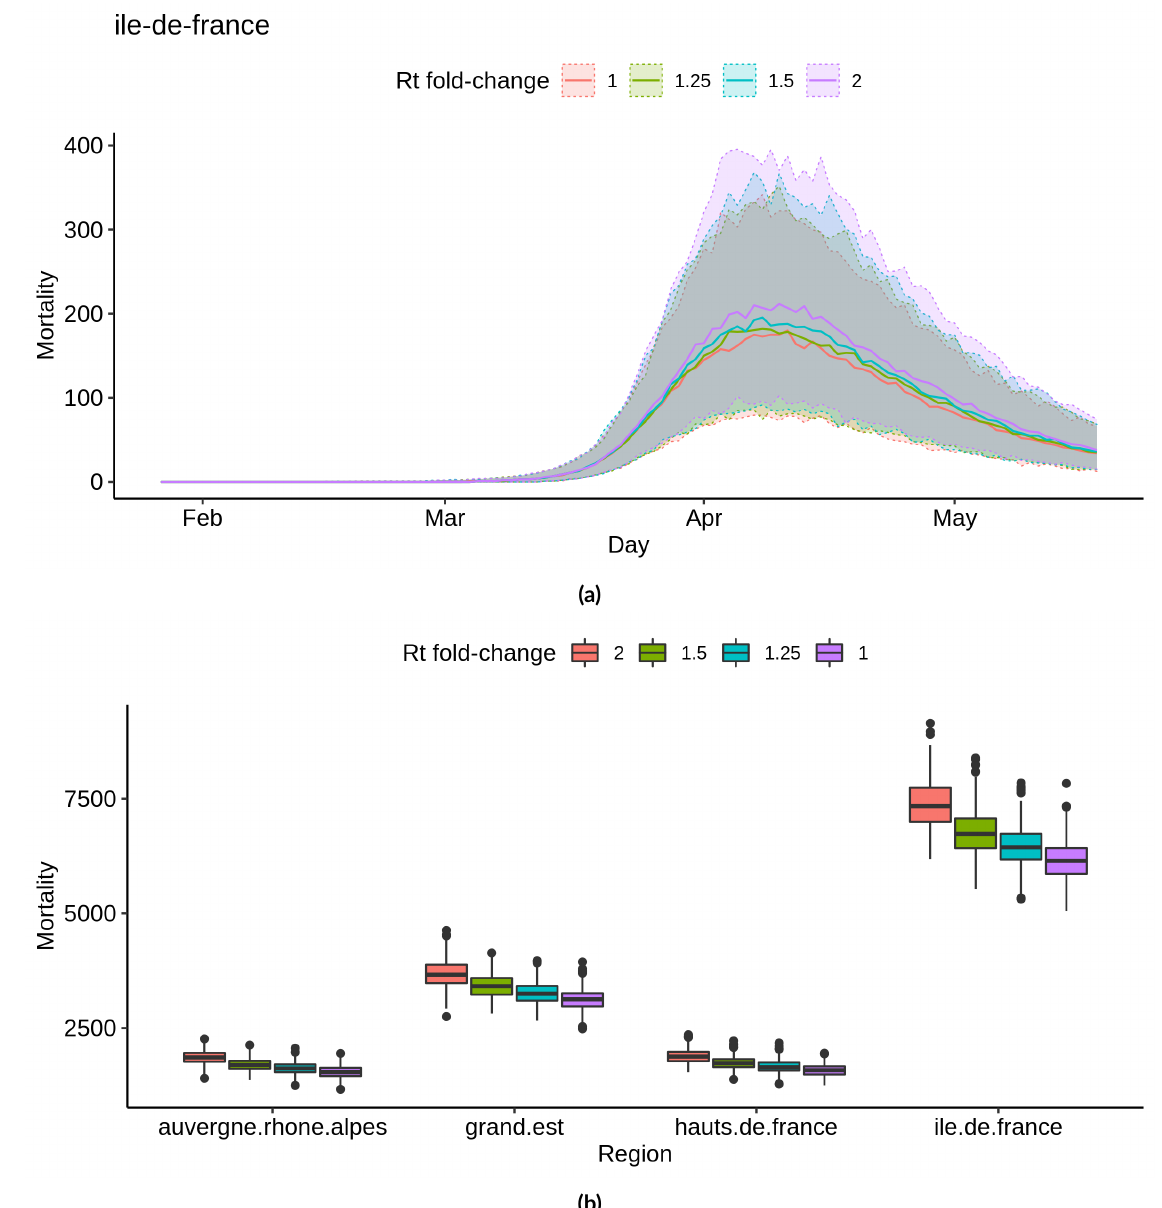
Figure 8 – Simulated distributions of deaths count, assuming different effect sizes of the election day on R t . (a) Simulated distribution of deaths through time in region Île-de- France. Median values are represented with a solid line, and shaded areas correspond to 95% credibility intervals. (b) Distributions of the total numbers of deaths in four regions. See Figure 6b for details on the